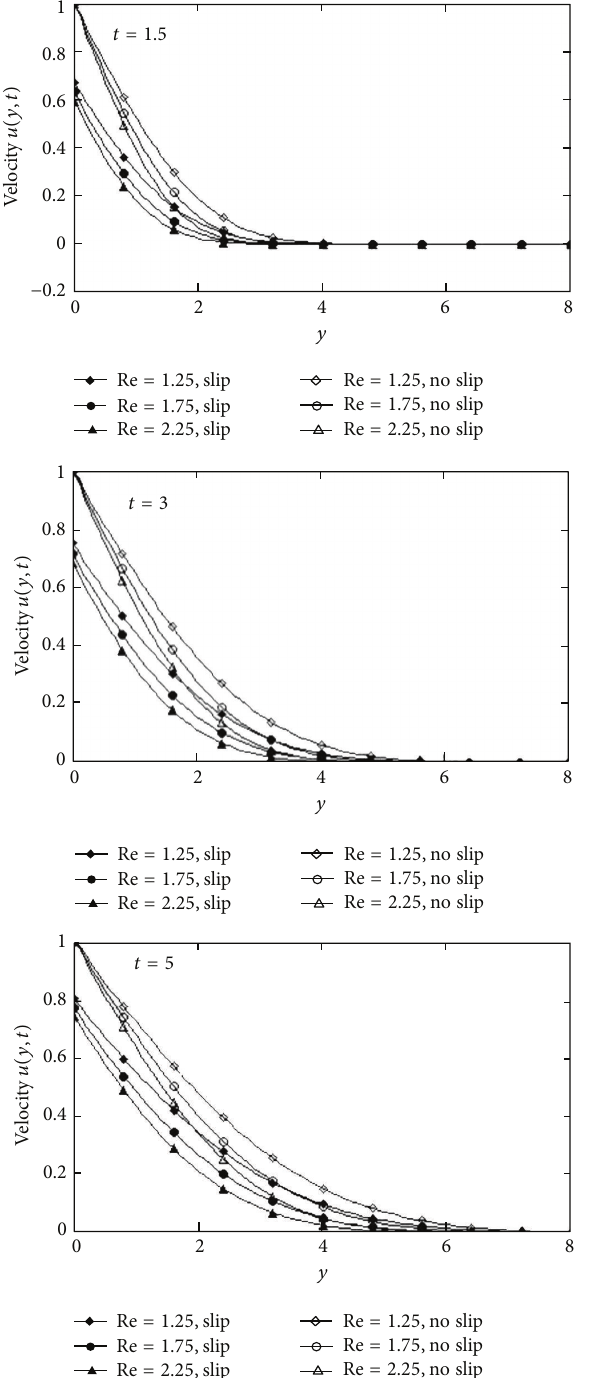
Figure 1: Velocity profiles of Oldroyd-B fluid for slip condition (16) with 𝛽 = 0.75 and no-slip condition (20) for 𝜆 = 0.25 , 𝜆 𝑟 = 0.15 , and different Reynolds